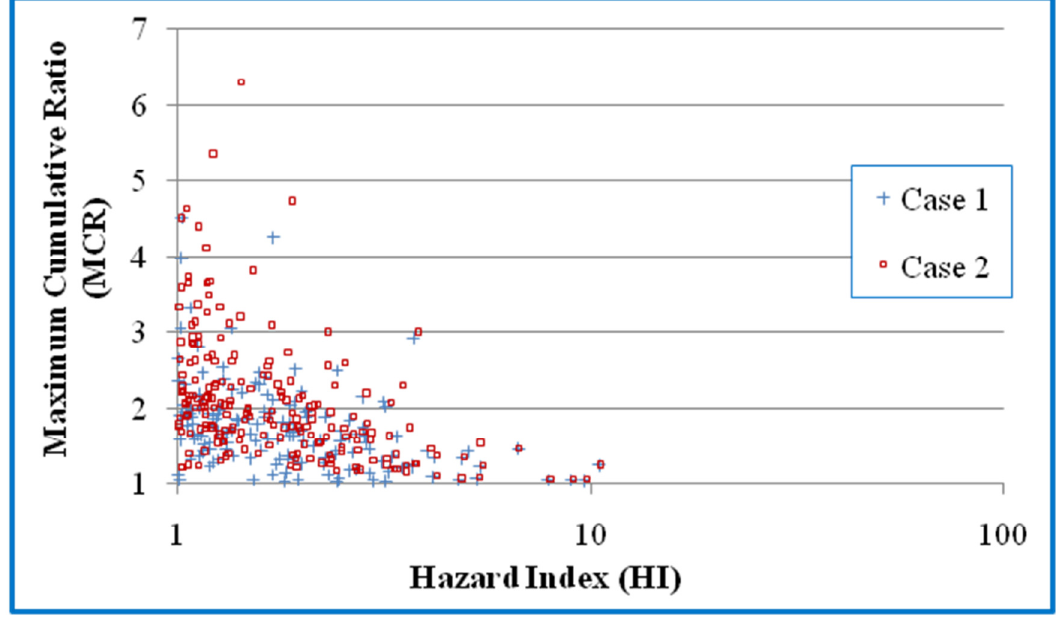
Figure 2. A scatter plot of the HI and MCR values for the mixtures with HI values greater than 1. Case 1 assumes that NDs have a concentration of 0 and Case 2 assumes that NDs have concentrations of DL/2 0.5 .